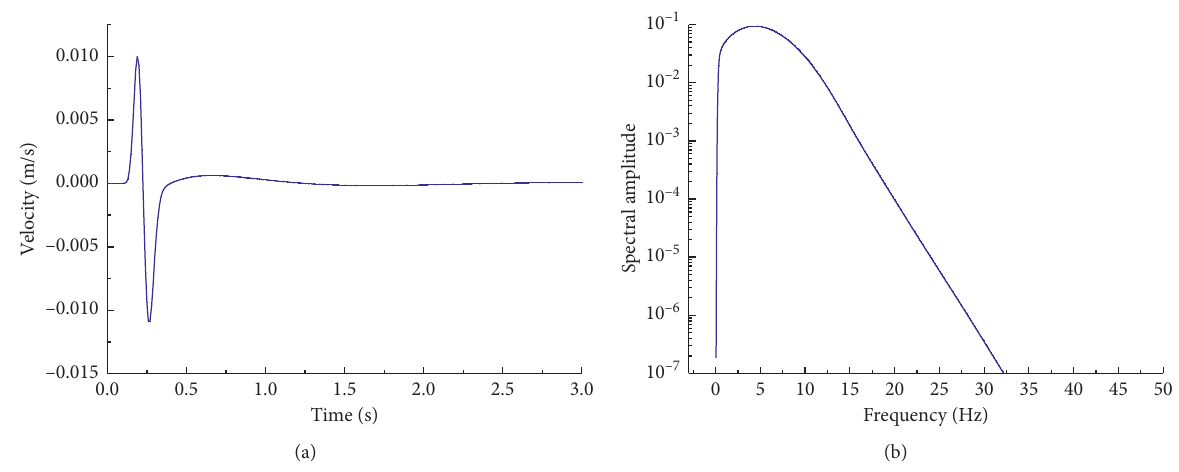
Figure 3: Time history of the impulsive load. (a) Time domain. (b) Fourier amplitude Figure 8. Time histories of relative horizontal displacements of dam crest and dam heel are shown in Figure 9. For the solutions by using the viscous-spring boundary and viscous boundary, the maximum horizontal displacements at dam crest are 17.43 cm and 17.36 cm, in which the relative error is 0.39%. The maximum horizontal displacements at dam heel are 17.387 cm and 17.311 cm, in which the relative error is 0.44%. The maximum relative horizontal displacements of dam crest and dam heel are − 5.13 cm and − 5.06 cm, in which the relative error is 1.47%. Time histories of horizontal accelerations at dam crest are plotted in Figure 10. For the solutions by using the viscous-spring boundary and viscous boundary, the maxi- mum horizontal accelerations at dam crest are 12.39 m/s 2 and 12.15 m/s 2 , in which the relative error is 1.87%. Time